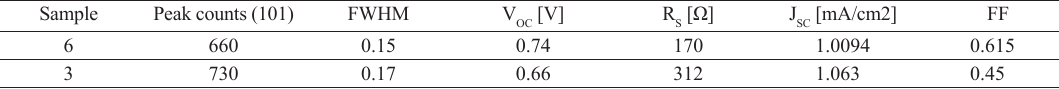
Table 4. Grain size of porous TiO Thickness [nm]